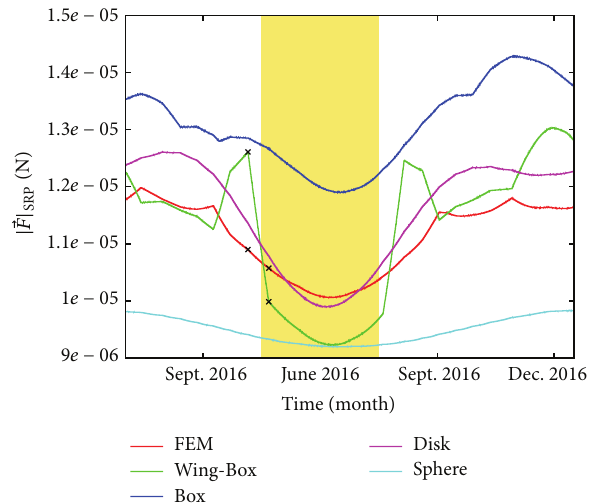
Figure 9: Resulting disturbance force due to SRP for different geometry models over one year. The yellow bar marks the time of